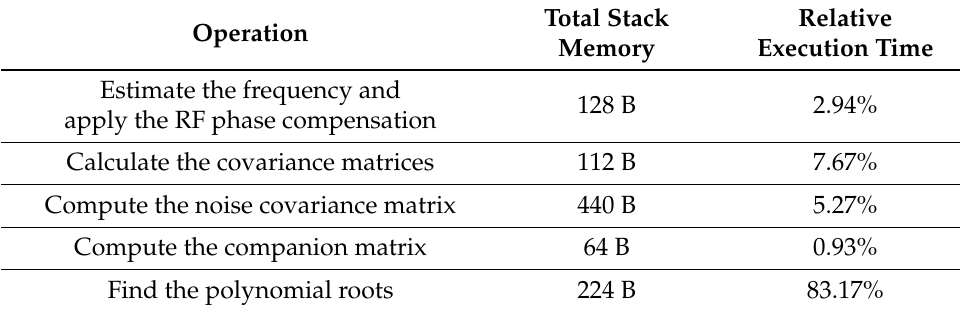
Table 3. Stack memory consumption and relative execution time of principal